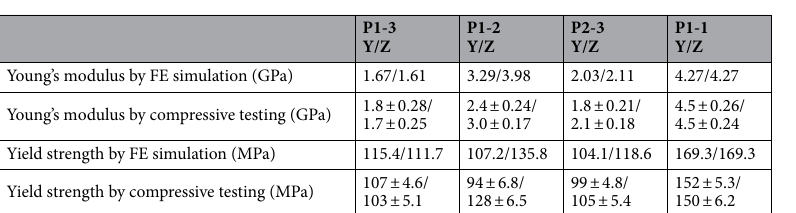
Table 2. Static characteristics of four groups of scaffolds (FE = finite